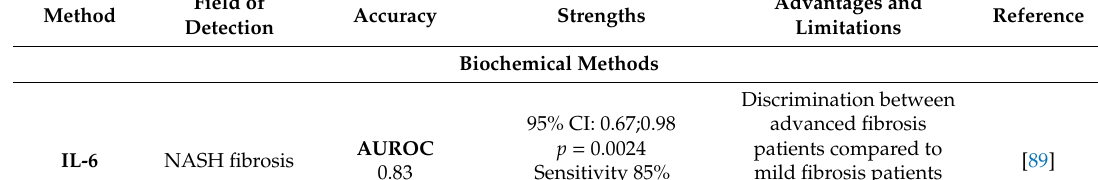
Table 2. Values of AUROC for the most accurate non-invasive biochemical methods.